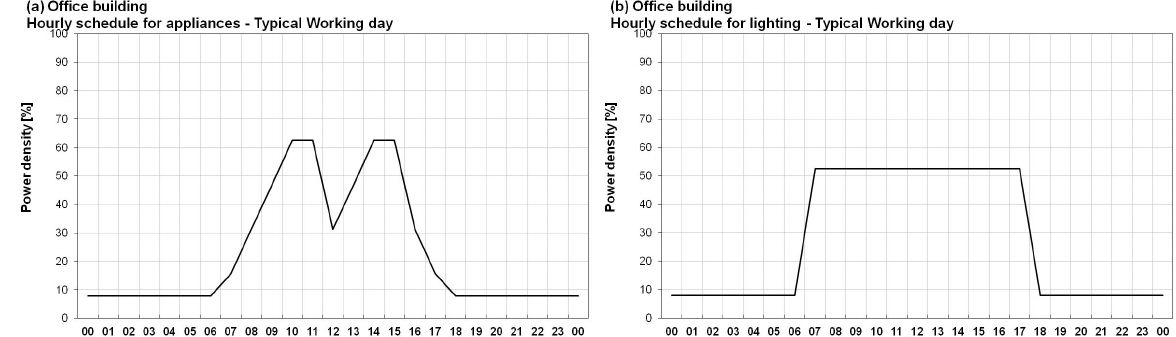
Figure 2. Hourly schedules for ( a ) appliances and ( b ) lighting use in residential buildings: focus on typical